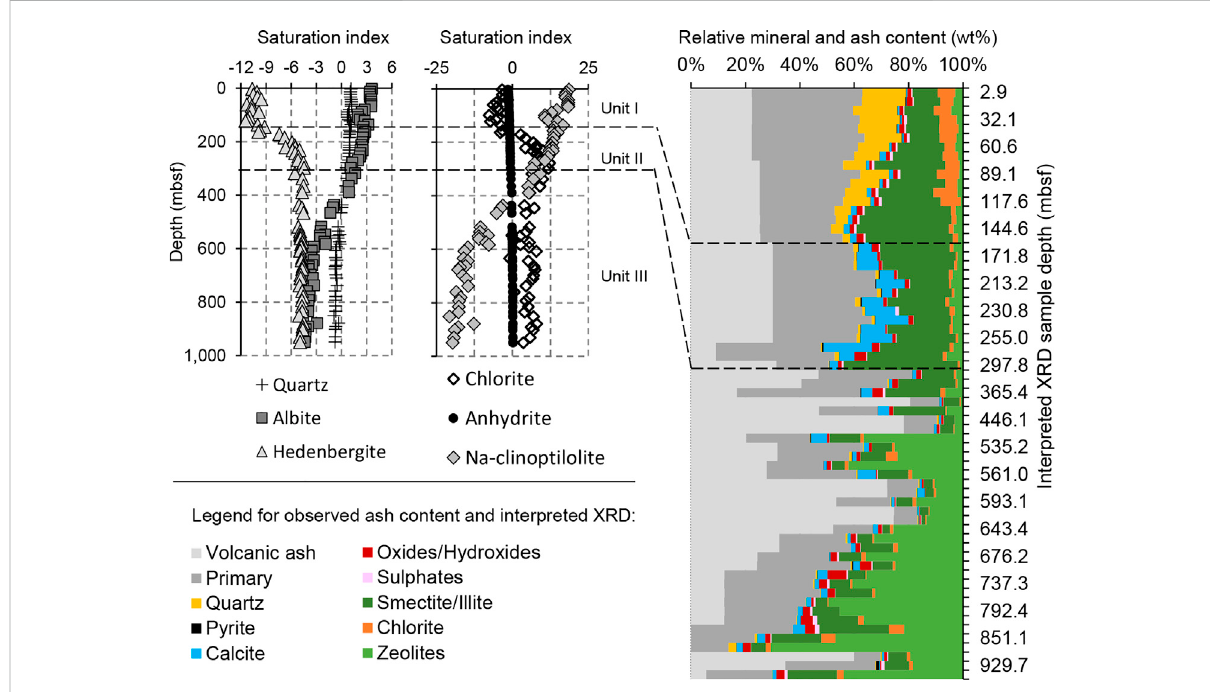
FIGURE 4 Calculated Saturation Indices (SI) of the porewaters with respect to selected primary (quartz, albite, and hedenbergite) and secondary minerals (Na-clinoptilolite, chlorite (clinochlore 14A), and anhydrite), observed volcanic ash content, and mineral abundance estimated from the XRD, corrected for the content of ash. XRD legend: “ Primary ” includes albite, anorthite, orthoclase, sanidine, microcline, muscovite, jadeite, diopside, enstatite, and fayalite; “ Oxides/Hydroxides ” include goethite, gibbsite, hausmannite, pyrolusite, and brucite; “ Zeolites ” include clinoptilolite, heulandite, laumontite, and analcime; “ Sulphates ” include anhydrite and